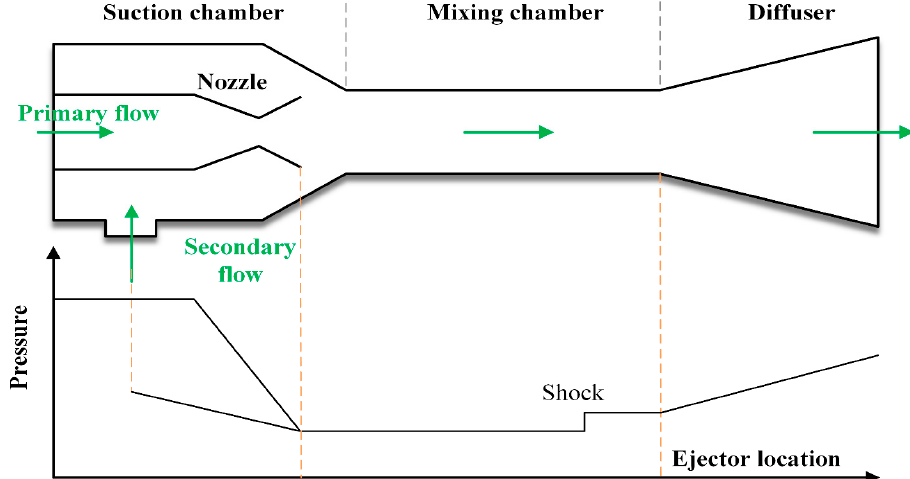
Figure 4. The structure and internal pressure change of the ejector in TERC.